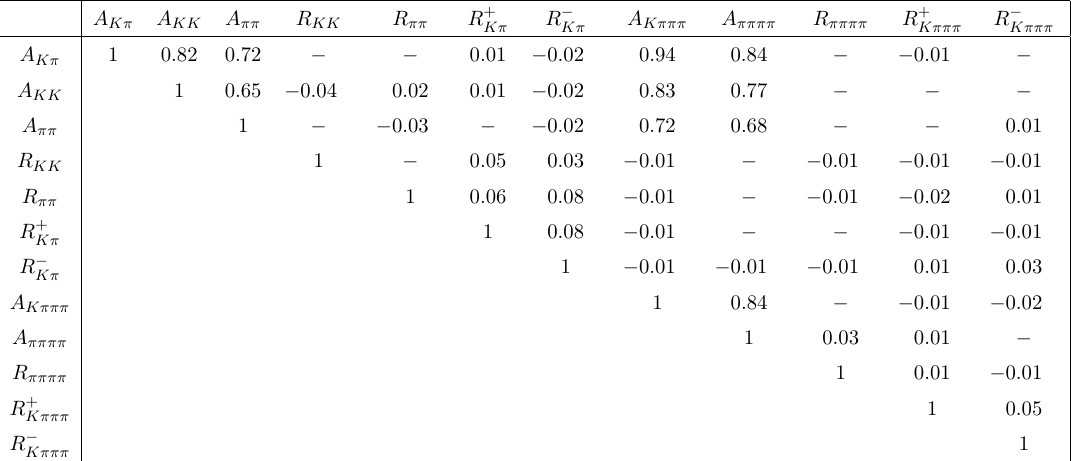
Table 4 . Correlation matrix of the systematic uncertainties for the twelve physics observables from the simultaneous (cid:12)t to data. Only half of the symmetric matrix is